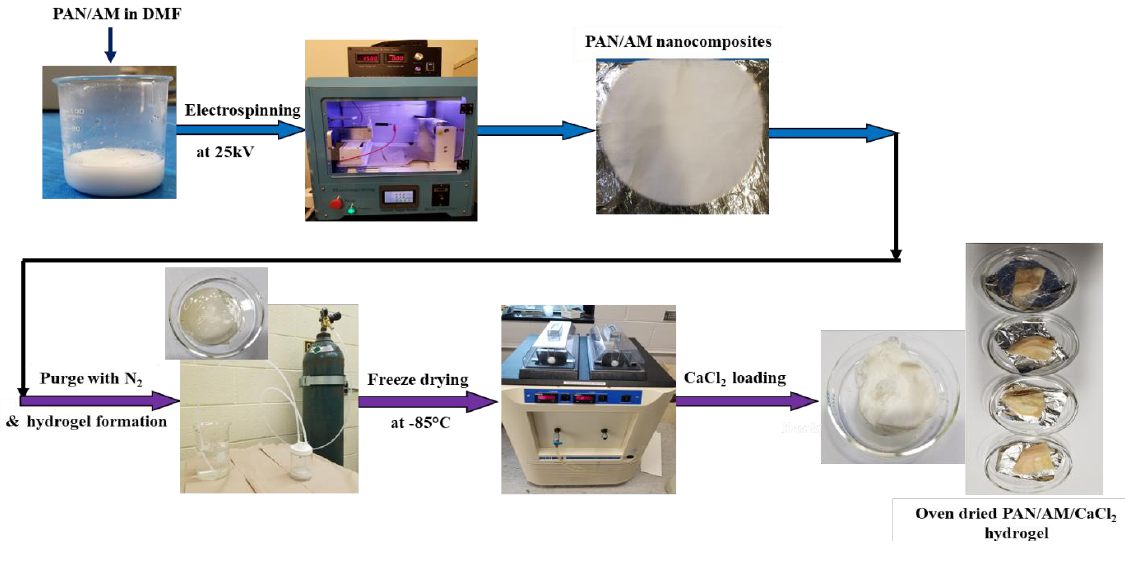
Figure 2. Step − by − step fabrication of PAN/AM/CaCl 2 hydrogel for atmospheric water collection.